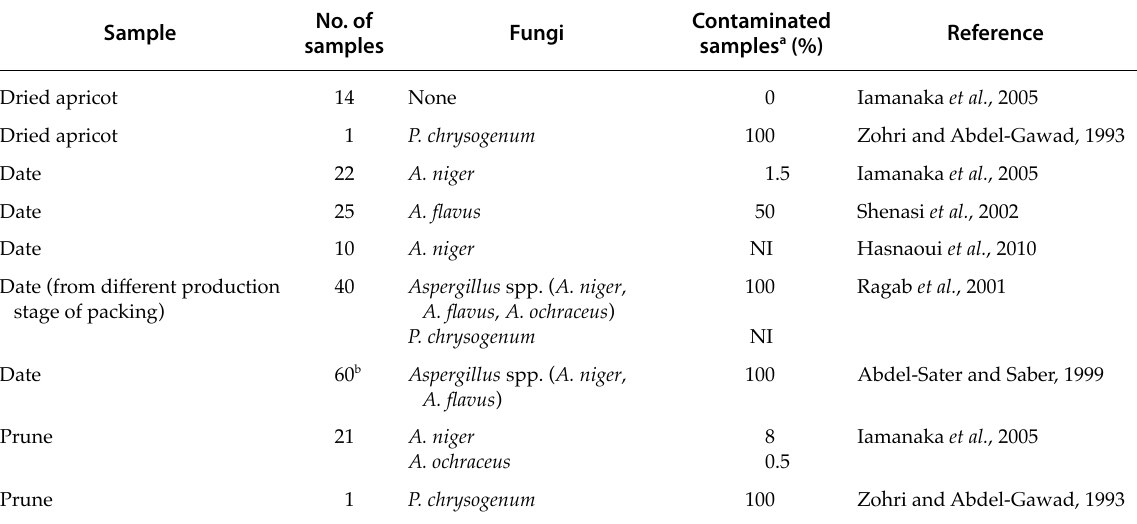
Table 1. Mycotoxigenic fungi in dried apricots, prunes and dates in Mediterranean crops.